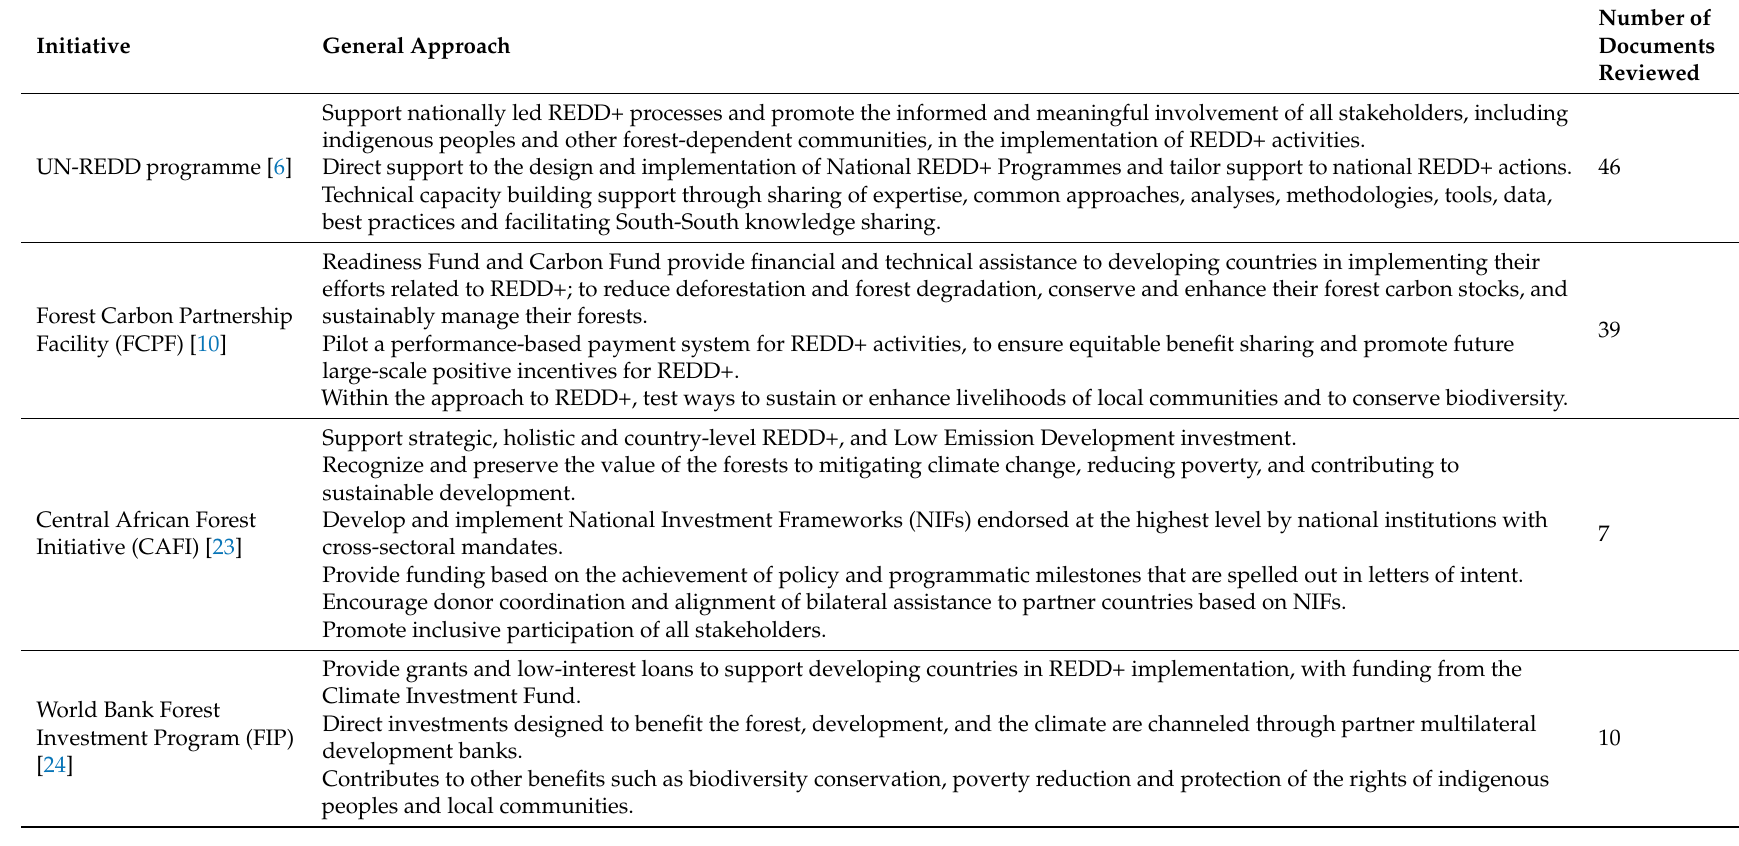
Table 1. General overview of approaches of the four